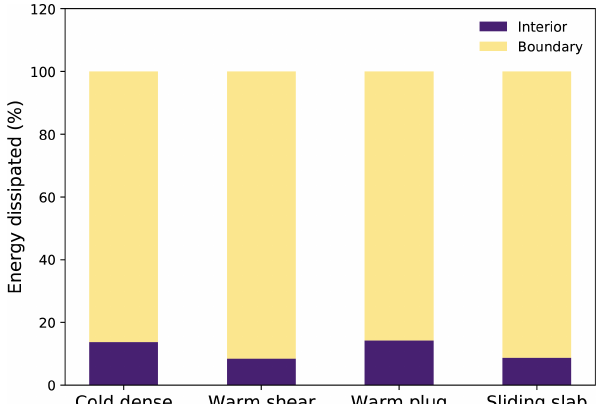
Figure A3. Energy dissipation inside the flow and through the boundary bed in the flows with the different flow